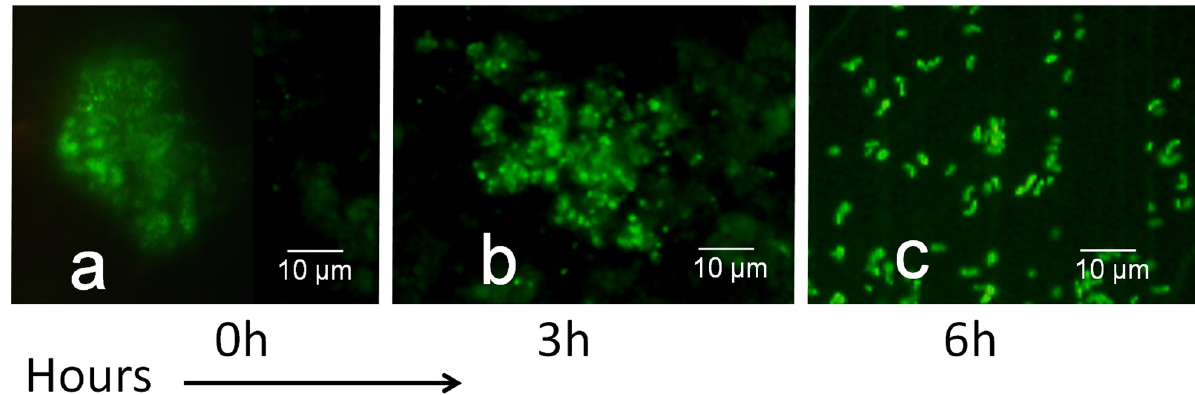
Fig 3. Fluorescent antibody based microscopic visualization of the CVEC resuscitation process. Multiple aliquots of water samples were incubated in LB medium containing equal volumes of cell-free spent culture supernatant of an AI-2 overproducing strain VC3625. Aliquots of samples were removed at regular time intervals, concentrated by centrifugation and monitored using fluorescent antibody based microscopy. Morphology of V . cholerae O1 CVEC at different time intervals of the resuscitation process are shown (panel a through c). In these samples, the morphology of cells changed gradually from a coccoid shape to more rod-like shape. These cellular changes corresponded to the recovery of viable cells at 6 hours of